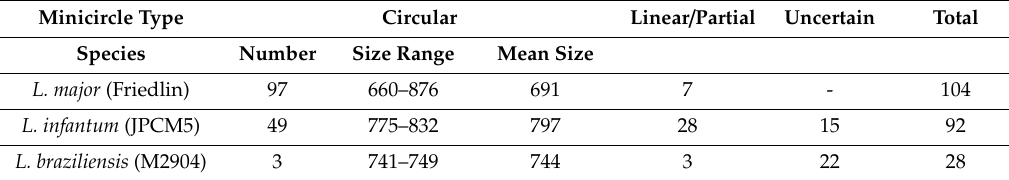
Table 2. Minicircles assembled in L. major , L. infantum and L.